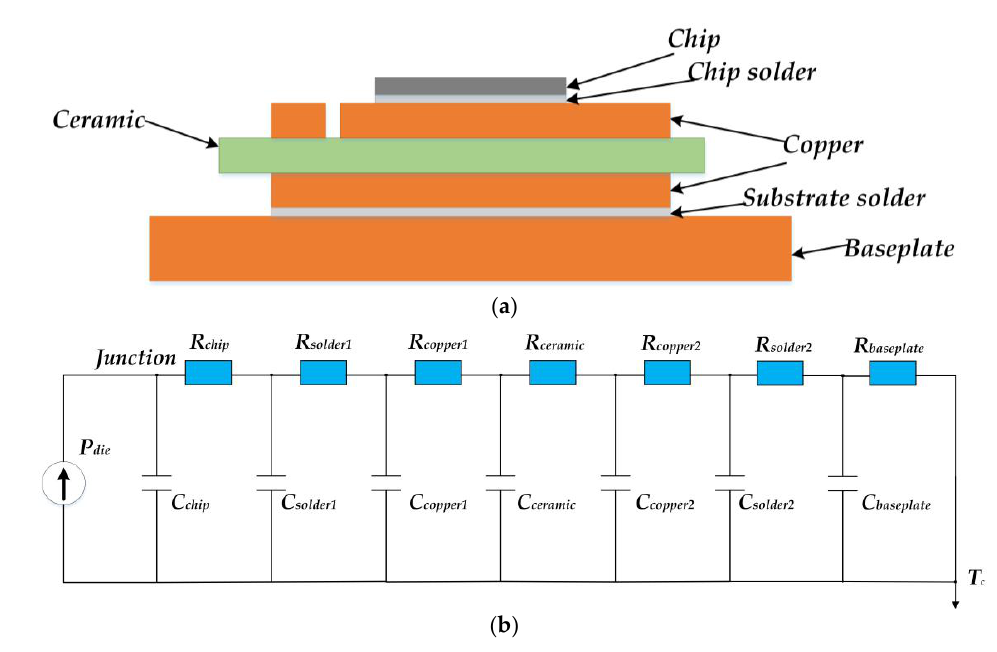
Figure 1. ( a ) Sandwich structure of IGBT; ( b ) Cauer-type thermal model.